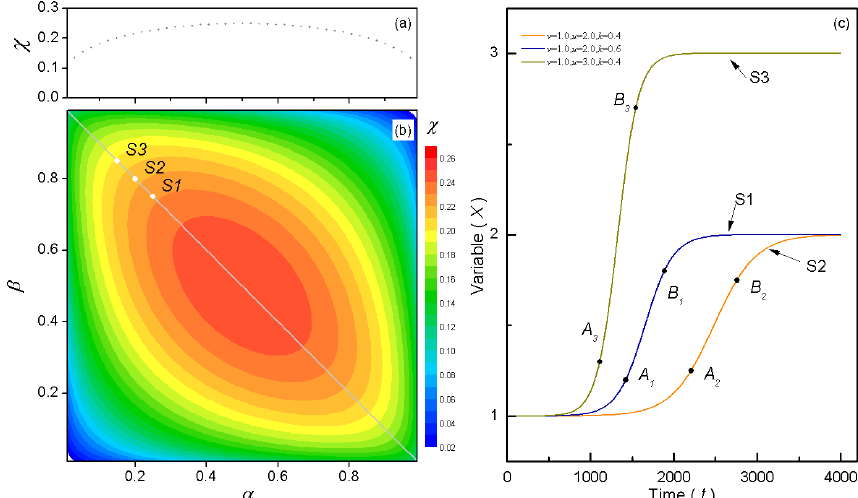
Figure 3. The relationship among the parameters α , β , χ and h . (a) Diagonal section of parameter χ in (b) (gray line). (b) Parameter χ with location parameters α and β . (c) Points A and B stay in different positions in the three situations marked as S1, S2 and S3, and the dashed lines connect the two